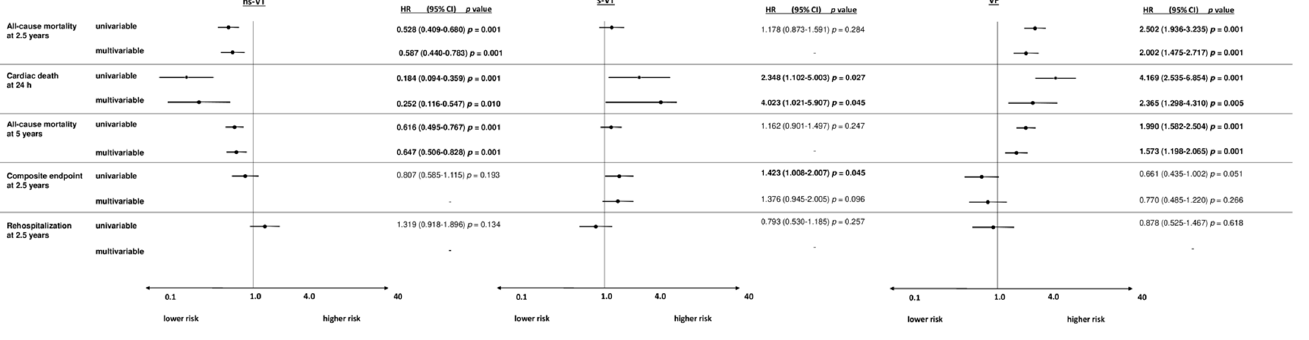
Figure 4. Forest plots demonstrating the uni- and multivariable hazard ratios (HR) with 95% confi- dence intervals (CI) for the primary endpoint all-cause mortality at 2.5 years, as well as for secondary endpoints all-cause mortality at 24 h, all-cause mortality at 5 years, the composite arrhythmic end- point (i.e., recurrent ventricular tachyarrhythmias, appropriate ICD therapies) at 2.5 years and cardiac rehospitalization at 2.5 years in IHD patients. Multivariable models were adjusted for age, sex, diabetes, chronic kidney disease, LVEF < 35%, COPD, the presence of a prior AMI, CABG and the presence of a CTO. HRs with corresponding 95% CI were calculated for the comparisons of patients with VF compared to s-VT, s-VT versus ns-VT and ns-VT versus s-VT and VF.